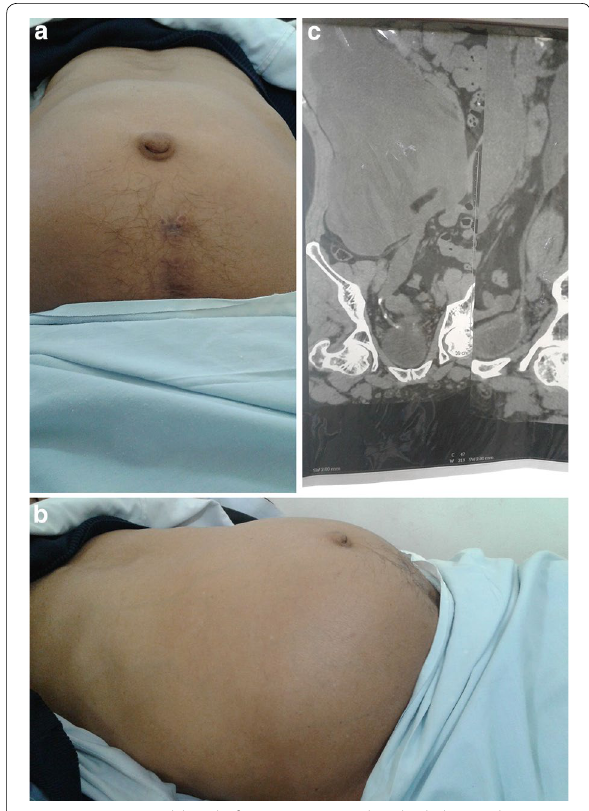
Fig. 1 A 58‑year‑old male farmer presented with abdominal distention mimicking ascites due to severe right hydronephrosis. Clinically visible right hydronephrosis seen in caudo‑cephalic ( a ) and lateral ( b ) views. A suprapubic midline scar for previous urinary bladder surgery is noted. c Non‑contrast multi‑slice computed tomography film showing bilateral hydronephrosis with severe right hydronephrosis and lost parenchymal thickness due to bilharzial ureteral stricture (note faint calcifications) and